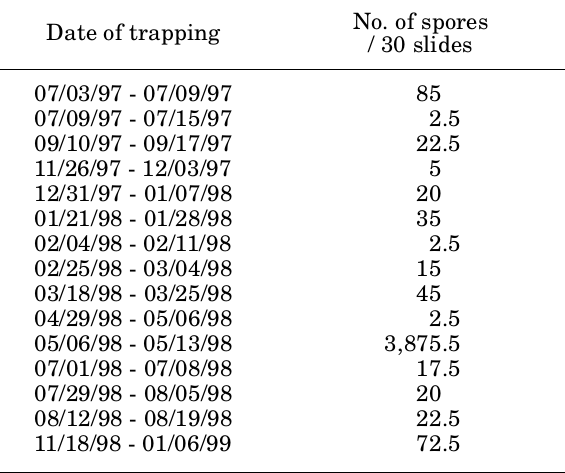
Table 2. Number of spores of P. chlamydosporum trapped between 29 January 1997 and 6 January